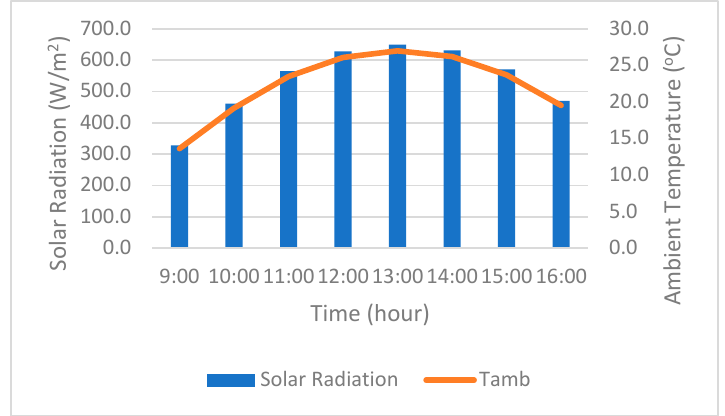
Figure 1. Hourly solar radiation and ambient temperature.